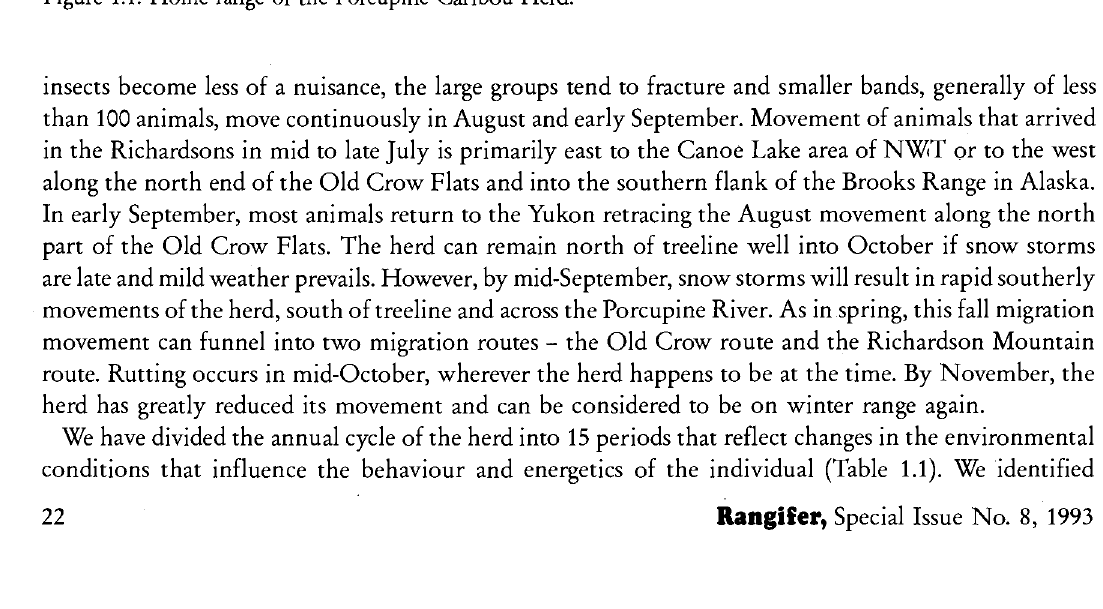
Figure 1.1. Home range of the Porcupine Caribou